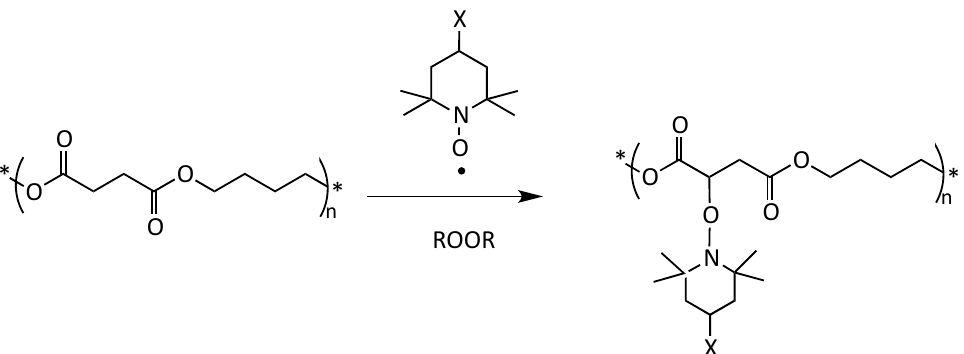
Scheme 1. Simplified mechanism of grafting of a functional TEMPO derivative onto a PBS polymer chain with a peroxide (ROOR) as initiator.